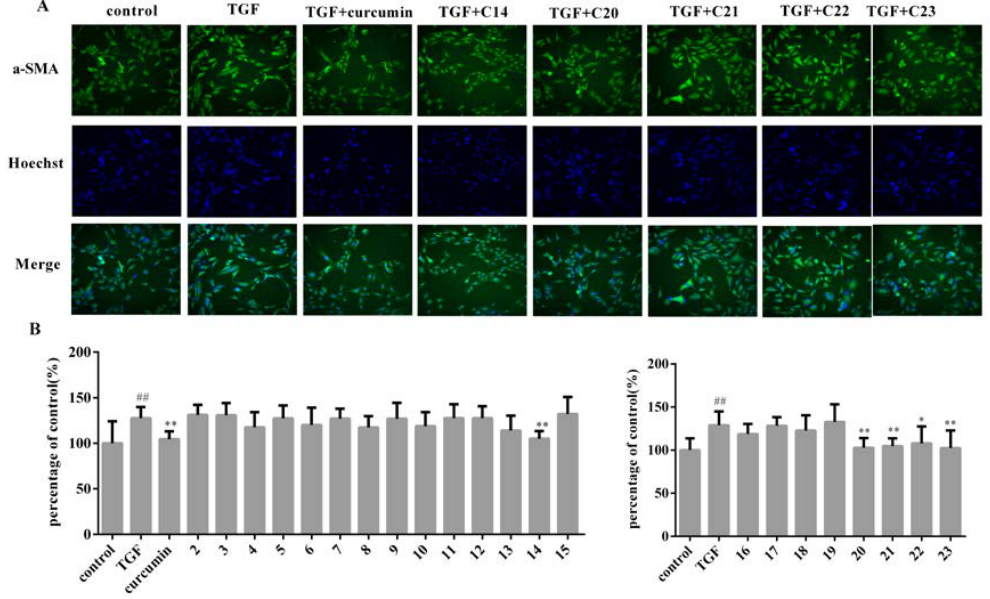
Figure 2. The screening results of anti-EMT fractions from TMYX. The fluorescence images of active components 14 , 20 , 21 , 22 , 23 ( A ) and the fluorescence intensity of components 2 – 23 from TMYX ( B ). The error bars represent standard deviation based on three repeated. All data was represented by Mean ± SD, ## p < 0.01, ** p < 0.01, * p < 0.05, n = 12 (single-trial).